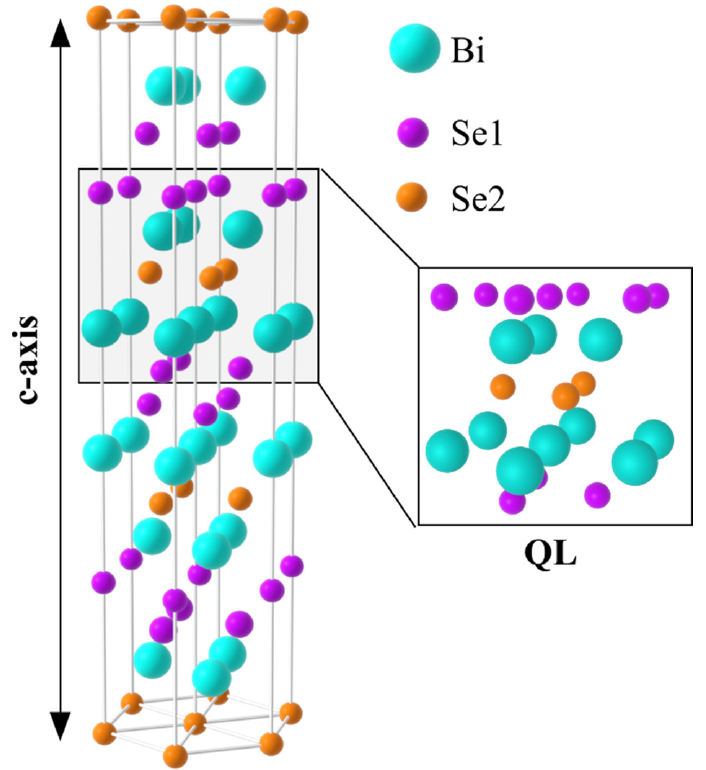
Figure 3. Schematic representation of the unit cell of rhombohedral Bi 2 Se 3 (blue: Bi, violet: Se1, orange: Se2) showing the Quintuple Layer (QL) arrangement and the c-axis direction.